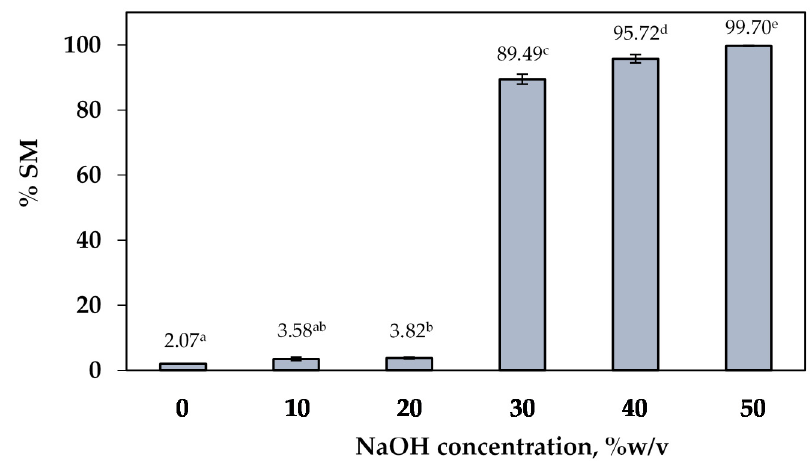
Figure 6. The effect of %SM on native rice starch film and CMSr films synthesized with 10%, 20%, 30%, 40%, and 50% NaOH concentrations. Different letters (a, b, c, d, e) indicate significant differences between CMSr films synthesized with various NaOH concentrations.